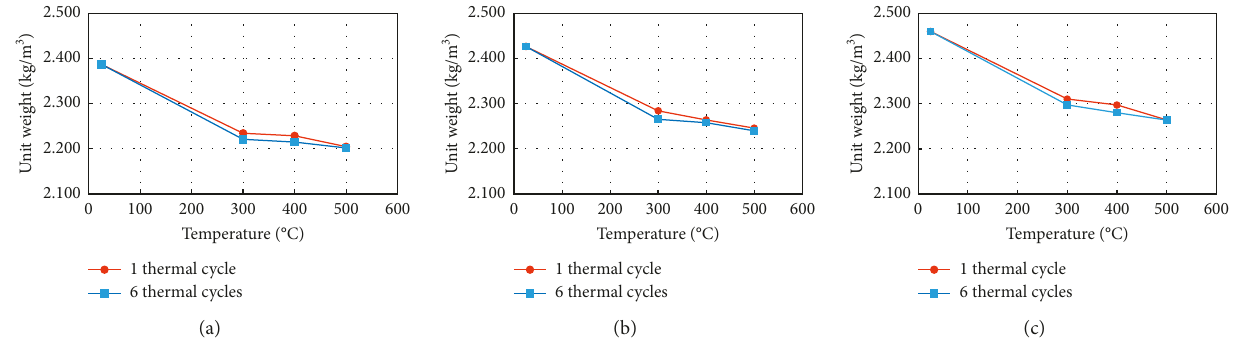
Figure 9: Comparison of unit weights after one and six thermal cycles. (a) Steel fiber content � 1.0%. (b) Steel fiber content � 1.5%. (c) Steel fiber content � 2.0%.